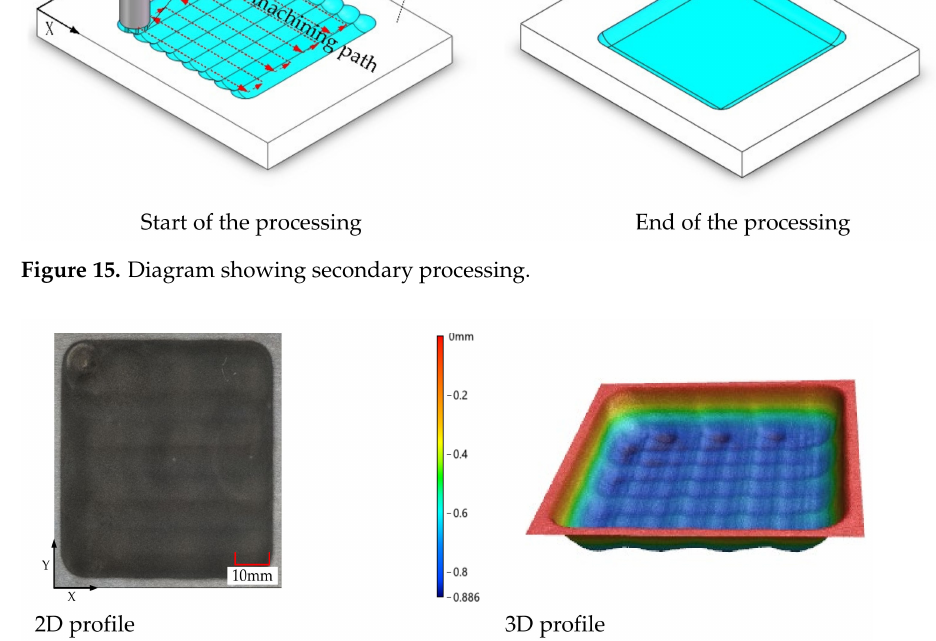
Figure 16. Diagram of secondary Processing of a flat